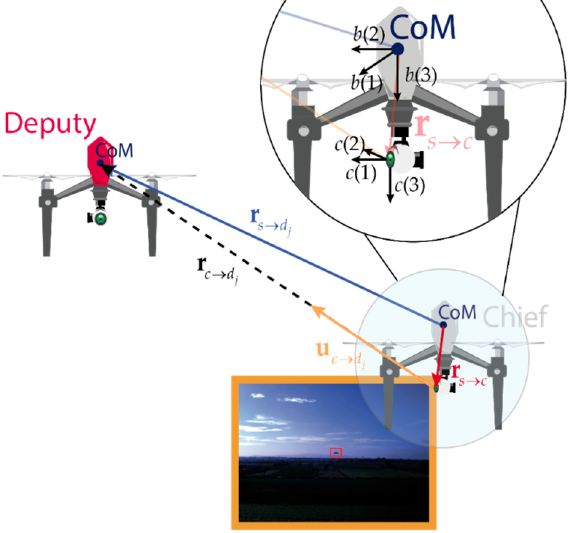
Figure 1. Cooperative navigation concept. Blue quantities are measured by CDGNSS techniques, orange quantities are estimated with cameras.